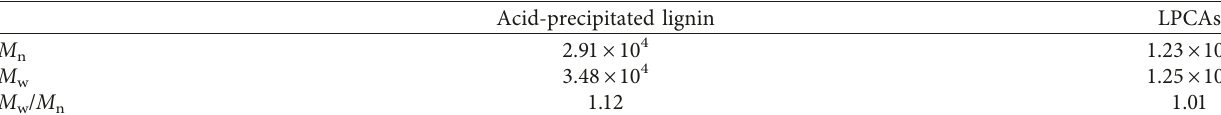
Table 3: The GPC characterization result of